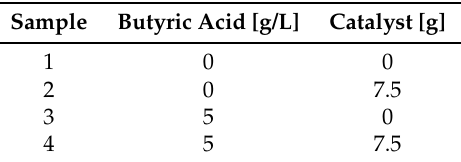
Table 2. Difference in the samples used for the sensory evaluation to determine if this process has an effect on the final